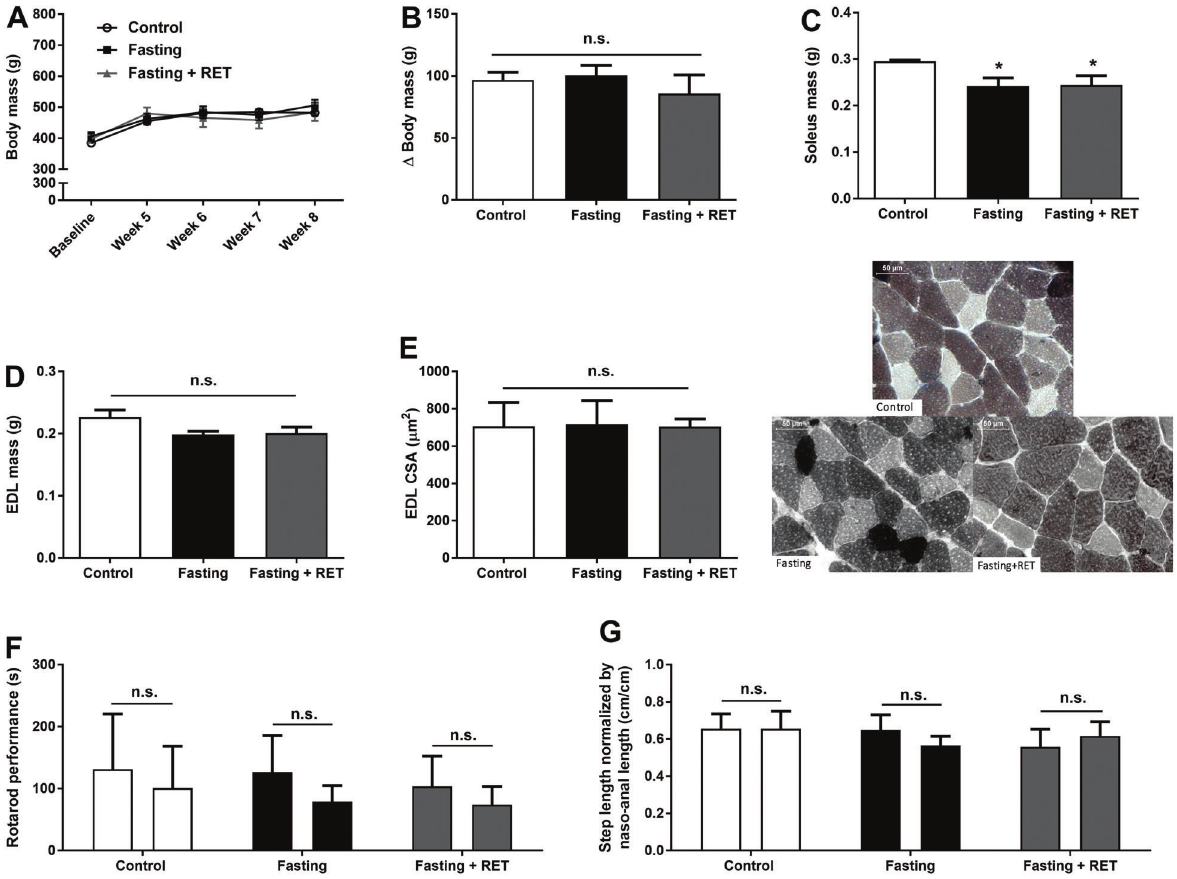
Figure 2. Effects of fasting during the long resistance exercise training (RET) protocol (second set of rats). Time-course of body mass ( A ), changes of body mass ( B ), soleus muscle mass ( C ), extensor digitorum longus (EDL) muscle mass ( D ), EDL fi ber cross-sectional area (CSA) and corresponding microphotograph ( E ), rotarod test performance pre- and post-RET protocol ( F ), and ambulation test performance pre- and post-RET protocol ( G ) for control, fasting and fasting + RET experimental groups. Data are reported as means ± SE (n=5). *P o 0.05 compared to the control group. n.s. indicates non-signi fi cant differences